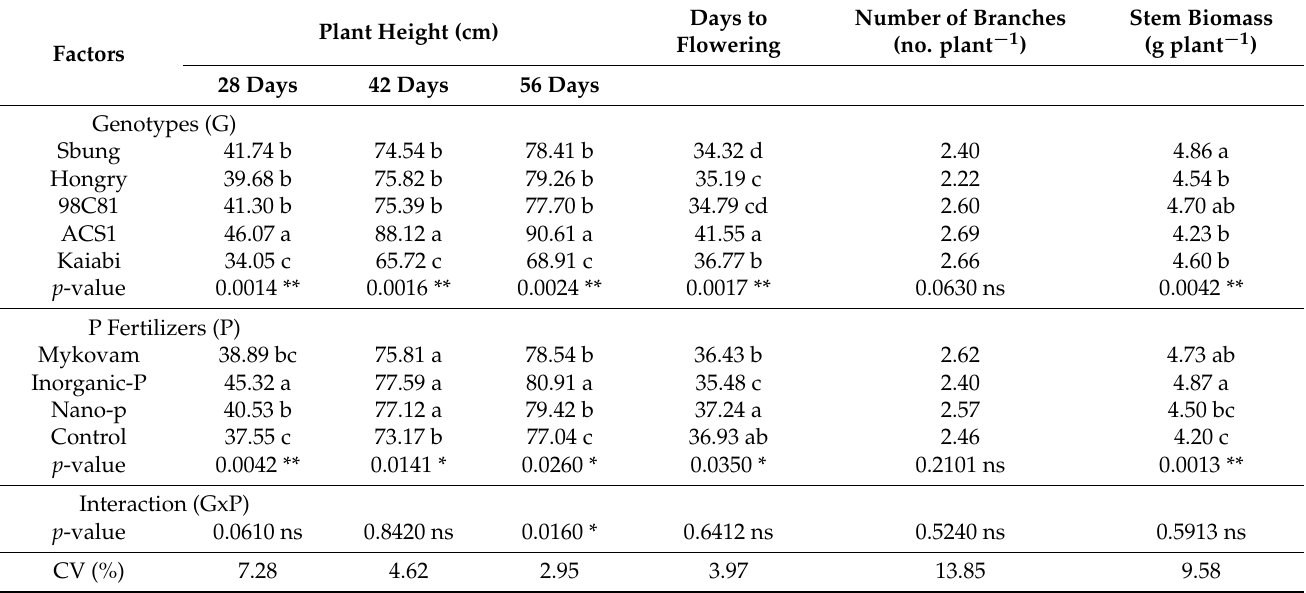
Table 7. Plant height at different days after growing, days to flowering, number of branches, and stem biomass, as affected by different genotypes and P fertilizer sources.